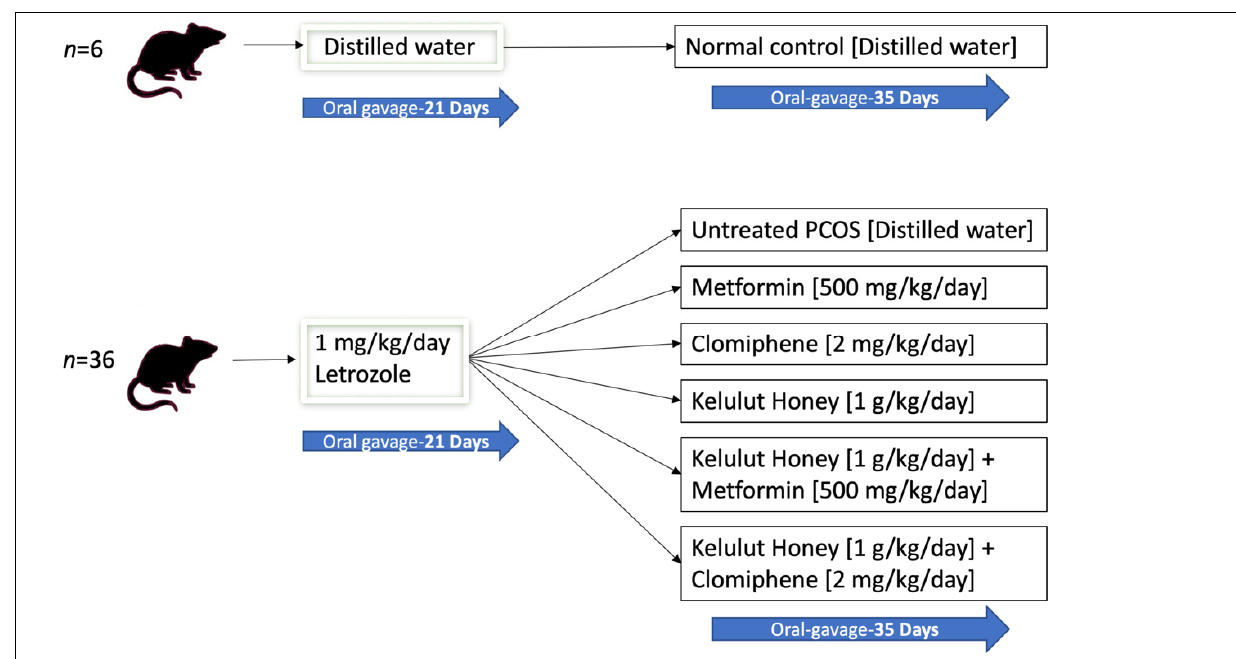
Figure 1. A schematic diagram of the animal grouping and